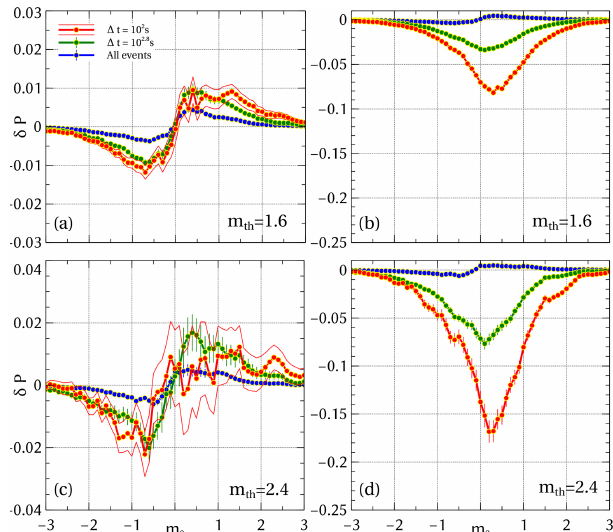
Figure 4. Magnitude correlations for the SSAR-SC catalog with (cid:49)t & M–D conditioning for sub-catalog randomizing (a, c) and full-catalog randomizing (b, d) for m th = 1 . 60 and 2.40. To see the trends clearly, only 1 σ error bars are shown.